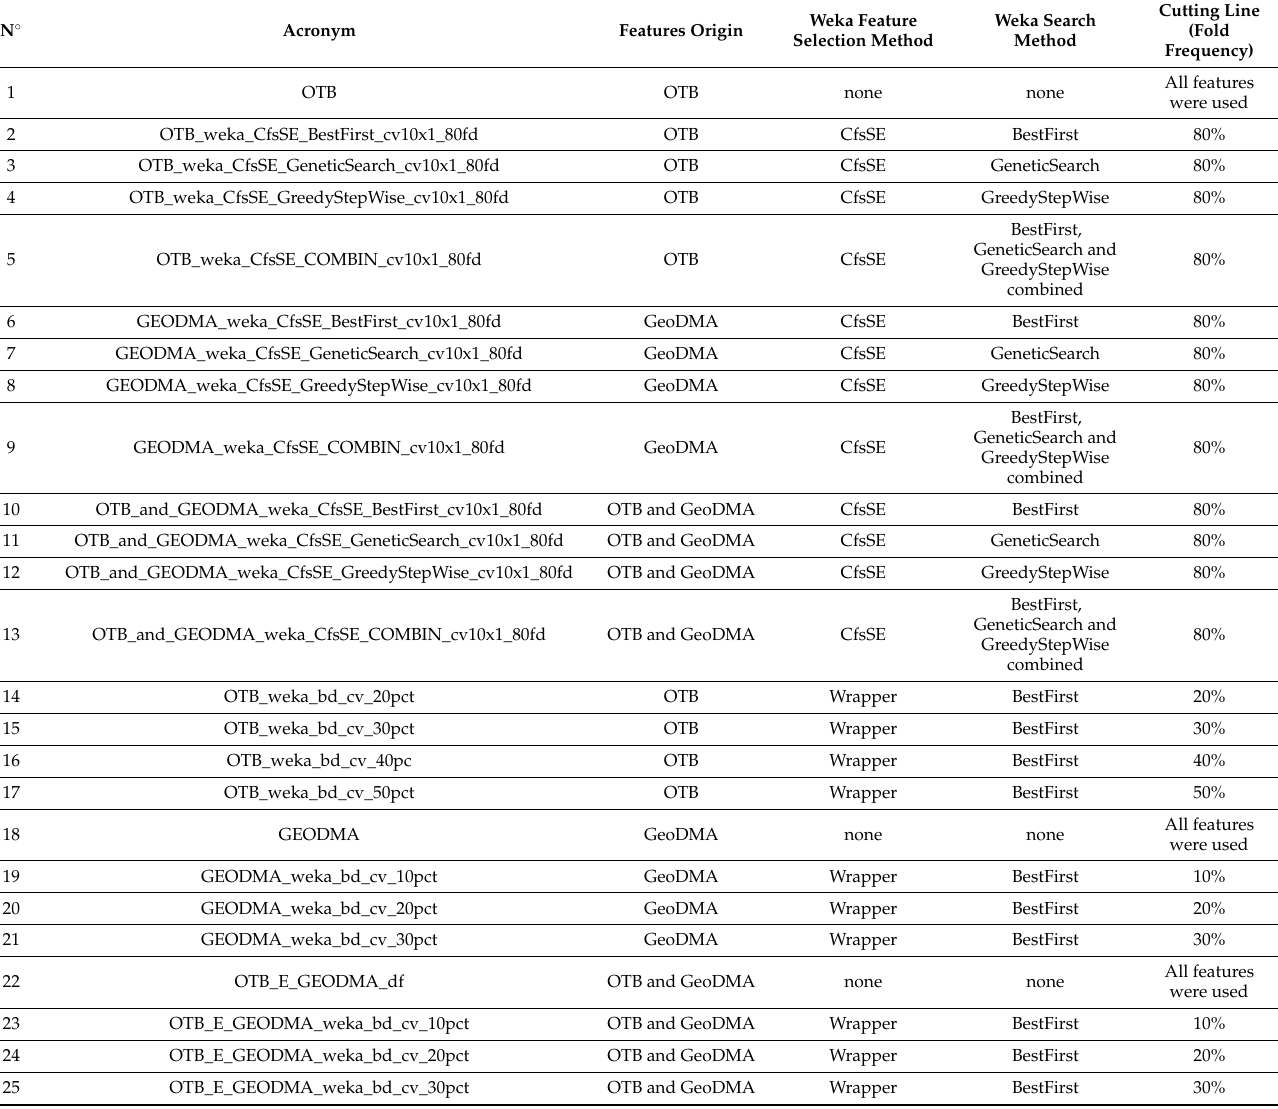
Table A3. List of acronyms to combine the attribute selection tested in the training and validation phases with the SVM and RF machine learning